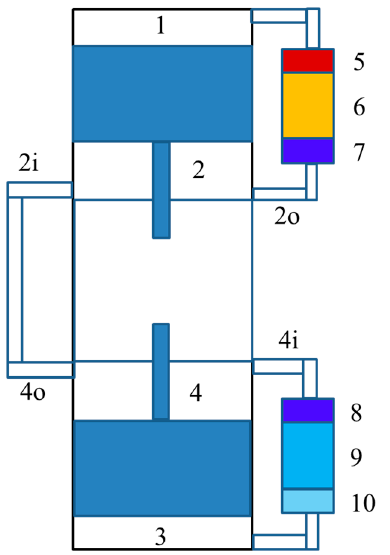
Figure 4. Schematic of four chambers Vuilleumier model.